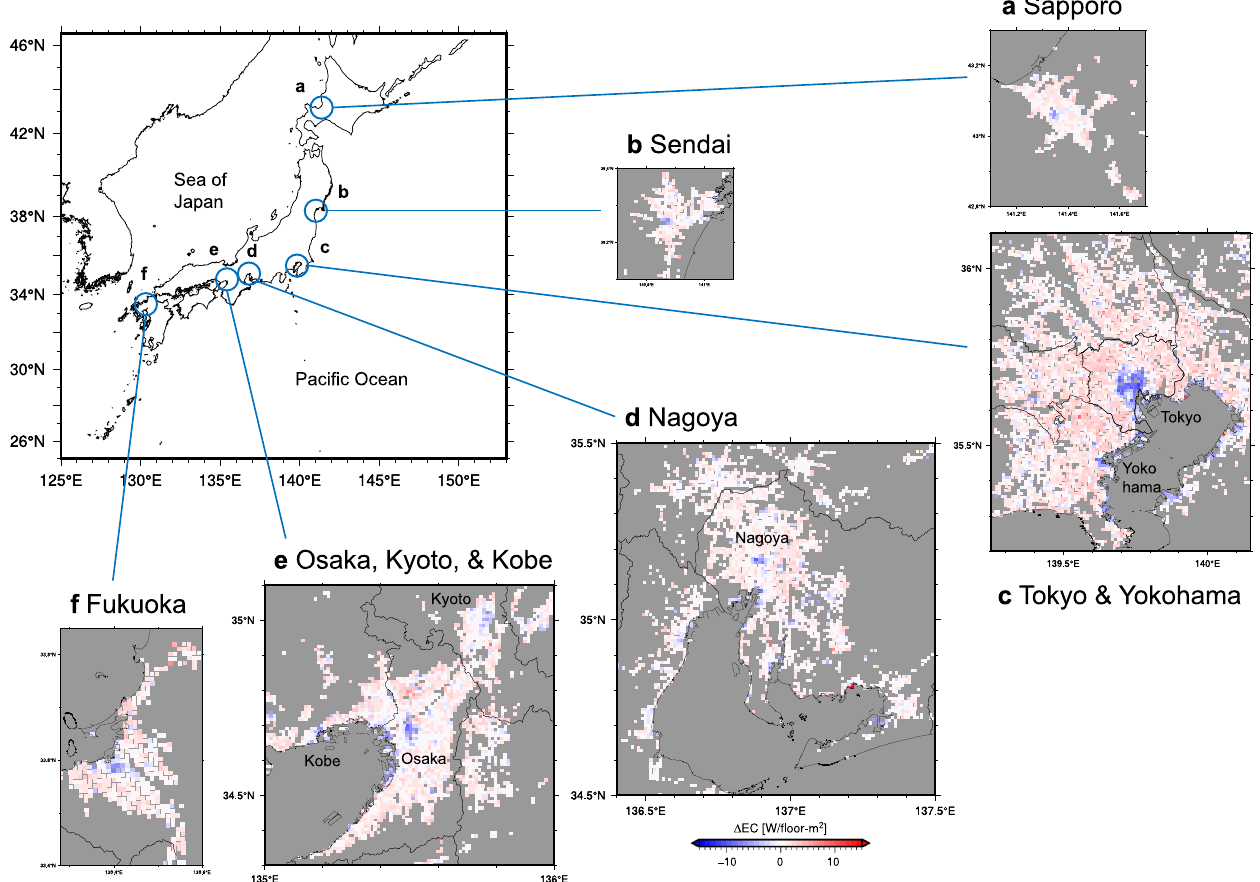
Fig. 3 Change in electricity consumption ( Δ EC ) for six major metropolises in Japan. a Sapporo (Hokkaido), b Sendai (Miyagi), c Tokyo (Tokyo) and Yokohama (Kanagawa), d Nagoya (Aichi), e Osaka (Osaka), Kyoto (Kyoto) and Kobe (Hyogo), and f Fukuoka